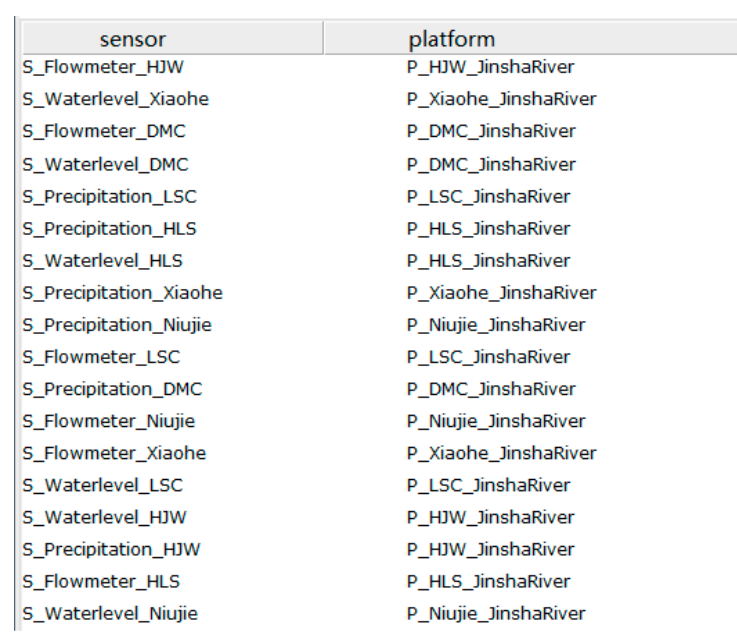
Figure 5. The search result of all sensors and platforms in the Jinsha River.